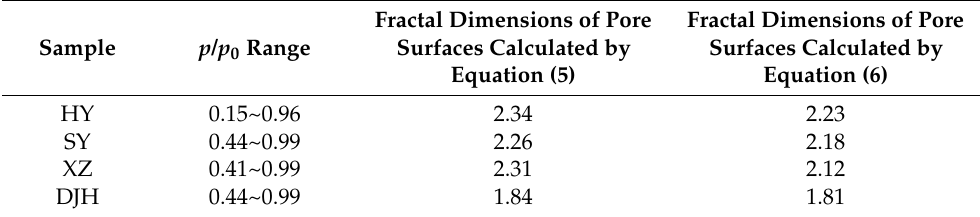
Table 6. Calculated fractal dimensions of pore